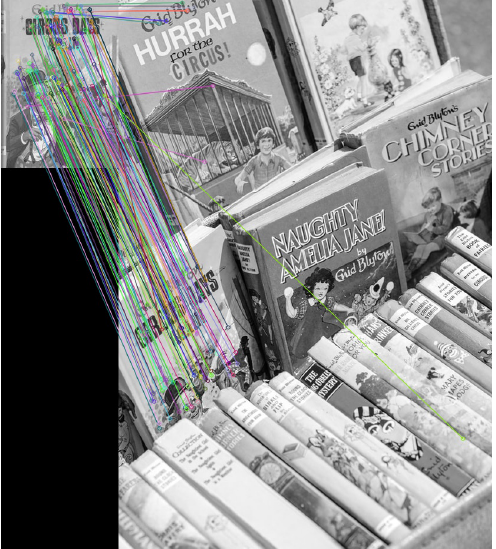
Figure 9. On the left, an image is given to the algorithm to extract its features. The features detected of the image are then compared with features of the right image. The lines illustrate the corresponding features between the two images. Adapted from